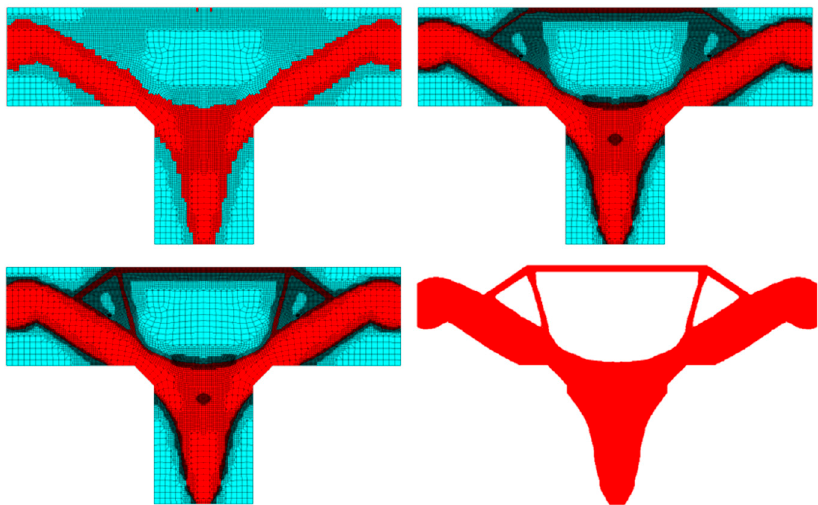
Figure 23. Selected middle topologies and the final one for the T-bracket structure - for the last iteration the grid has not been shown to improve the clarity of the picture.